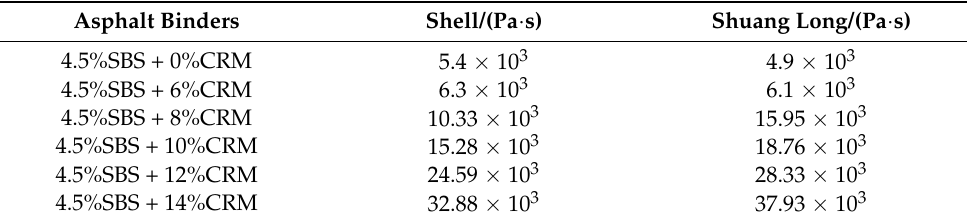
Table 4. ZSV Values of hybrid modified asphalt binders (fixed SBS and various